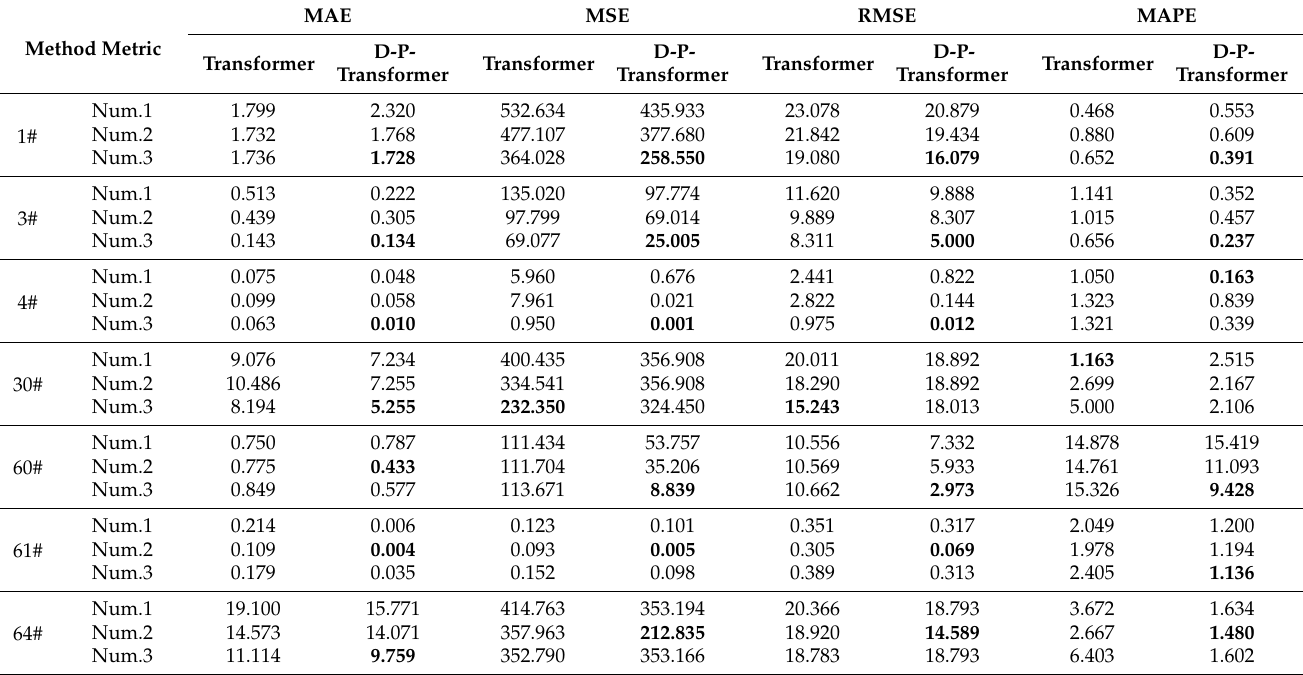
Table 3. The metrics of the D-P-Transformer and Transformer algorithms on different